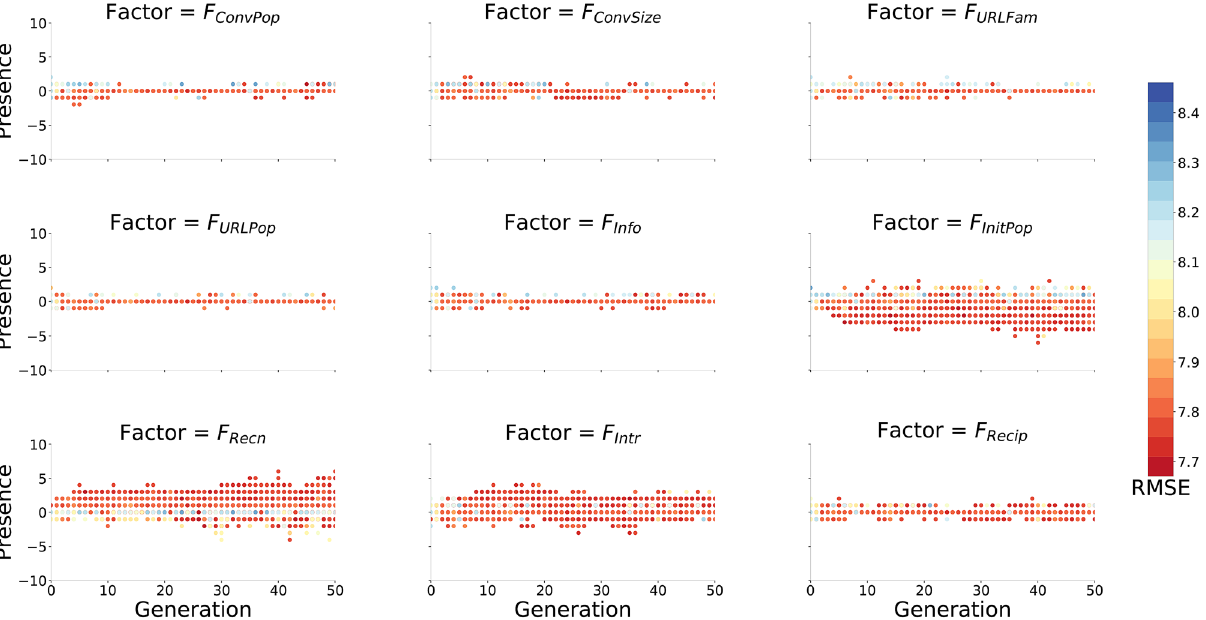
Figure 2. Selection of primitives by generation with the simulation RMSE produced. Causal factors that had higher contribution to response prioritization are expected to have higher selection pressure on the genetic program, exhibiting increasing negative or positive bias in presence within u ( m ) over generations. Results have been averaged over the 20 genetic program runs and red indicates lower RMSE. F InitPop , F Recn , and F Intr show a gradual increase the different presence values in u ( m ) explored by the genetic program in comparison to other factors considered.